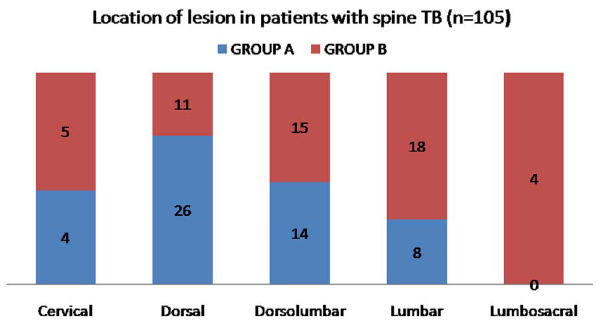
Figure 2. Location of lesion in patients with spine TB ( n = 105). Group A – patients with neurological de fi cit ( n = 52). Group B – patients without de fi cit ( n = 53).